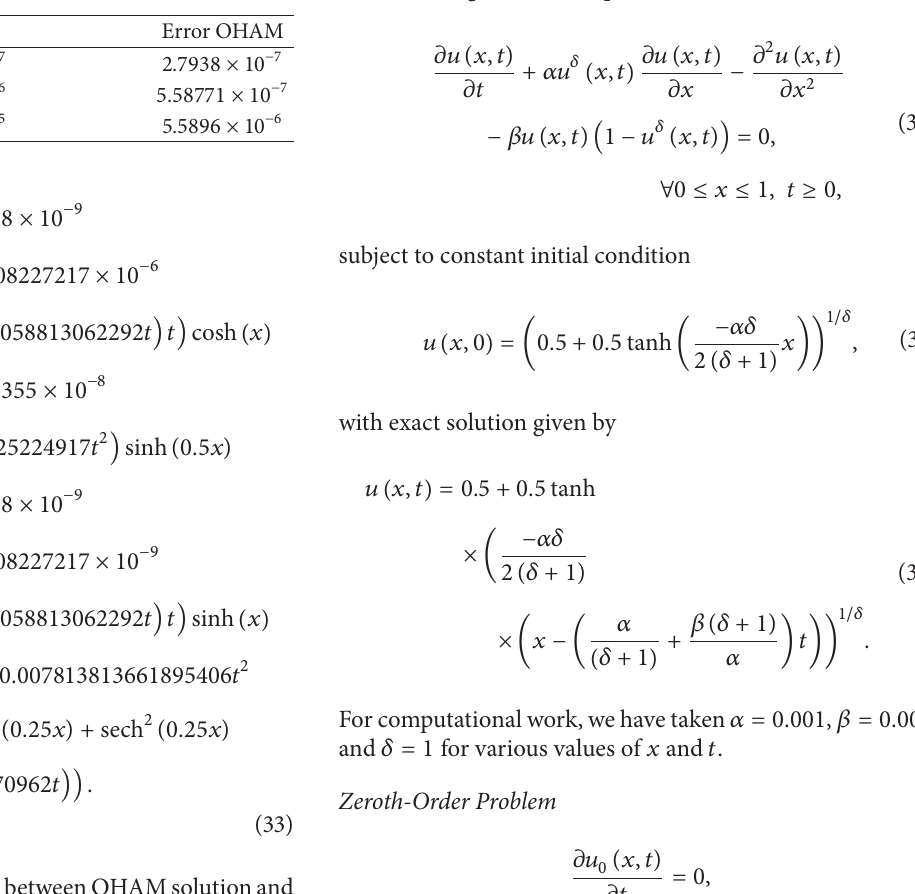
Table 3: Comparison of absolute errors obtained by OHAM and ADM [5] for 𝛼 = 0 , 𝛽 = 1 , 𝛿 = 2 , and 𝛾 = 0.001